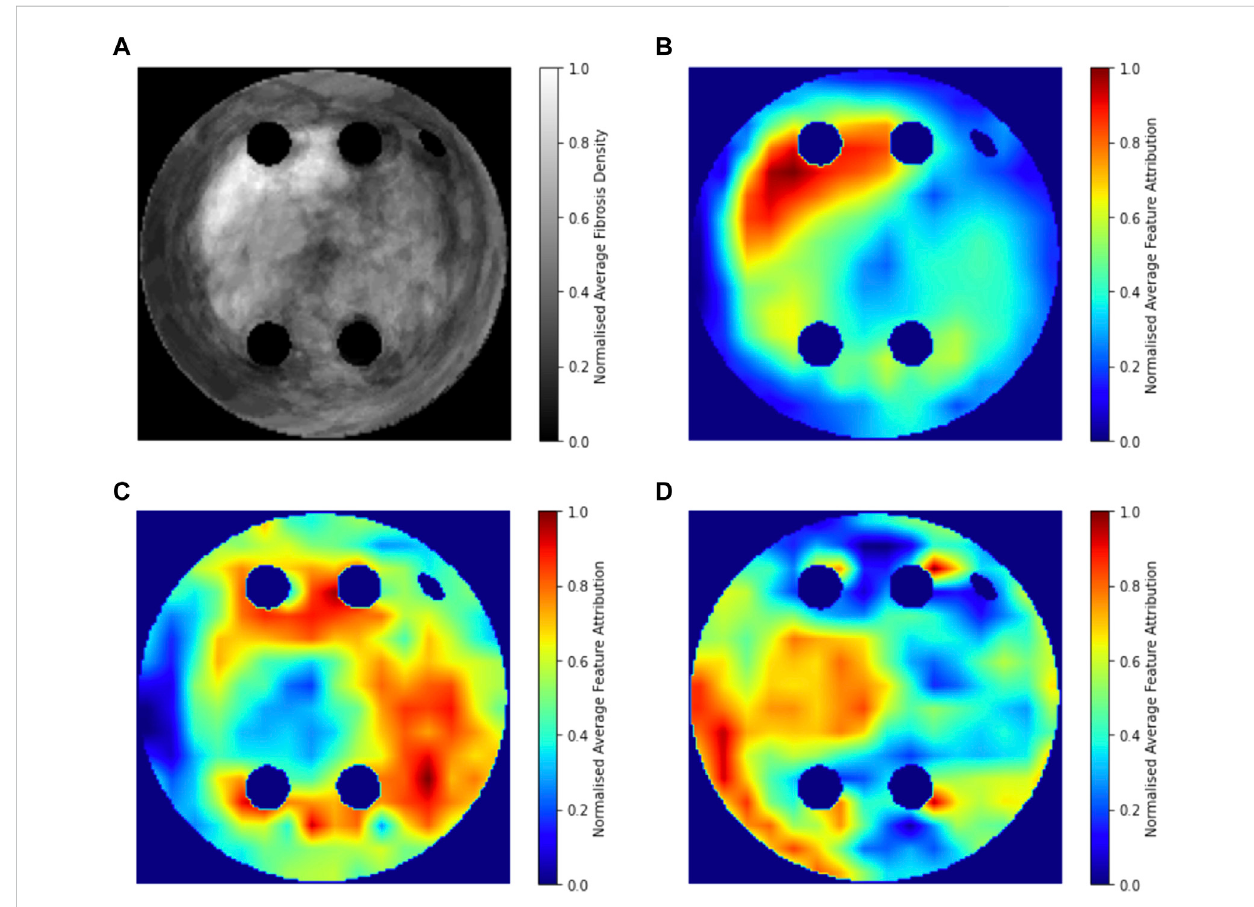
FIGURE 8 Averaged LGE MRI intensities and FA maps on the hold-out test set. (A) . Averaged and normalised LGE MRI intensity in the LA tissue disks. (B) . Averaged and normalised GradCAM FA map for the ROTOR ablation strategy. (C) . Averaged and normalised GradCAM FA map for the FIBRO ablation strategy. (D) . Averaged and normalised GradCAM FA map for the PVI ablation